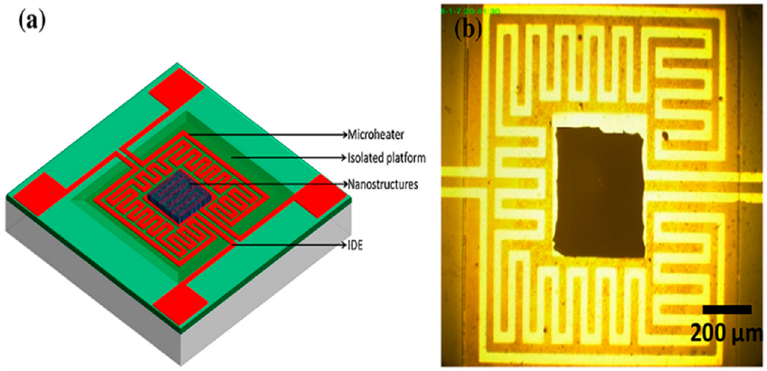
Figure 14. ( a ) Micro-hotplate structure, ( b ) MEMS sensor with sputtered ZnO-CuO thin film [35].